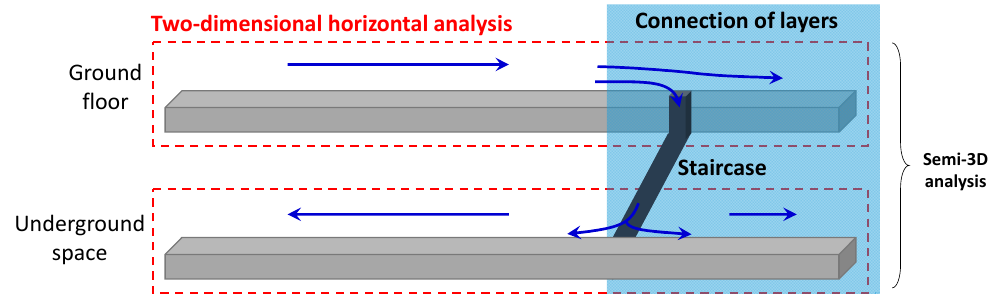
Figure 1. Inundation analysis in two layers.